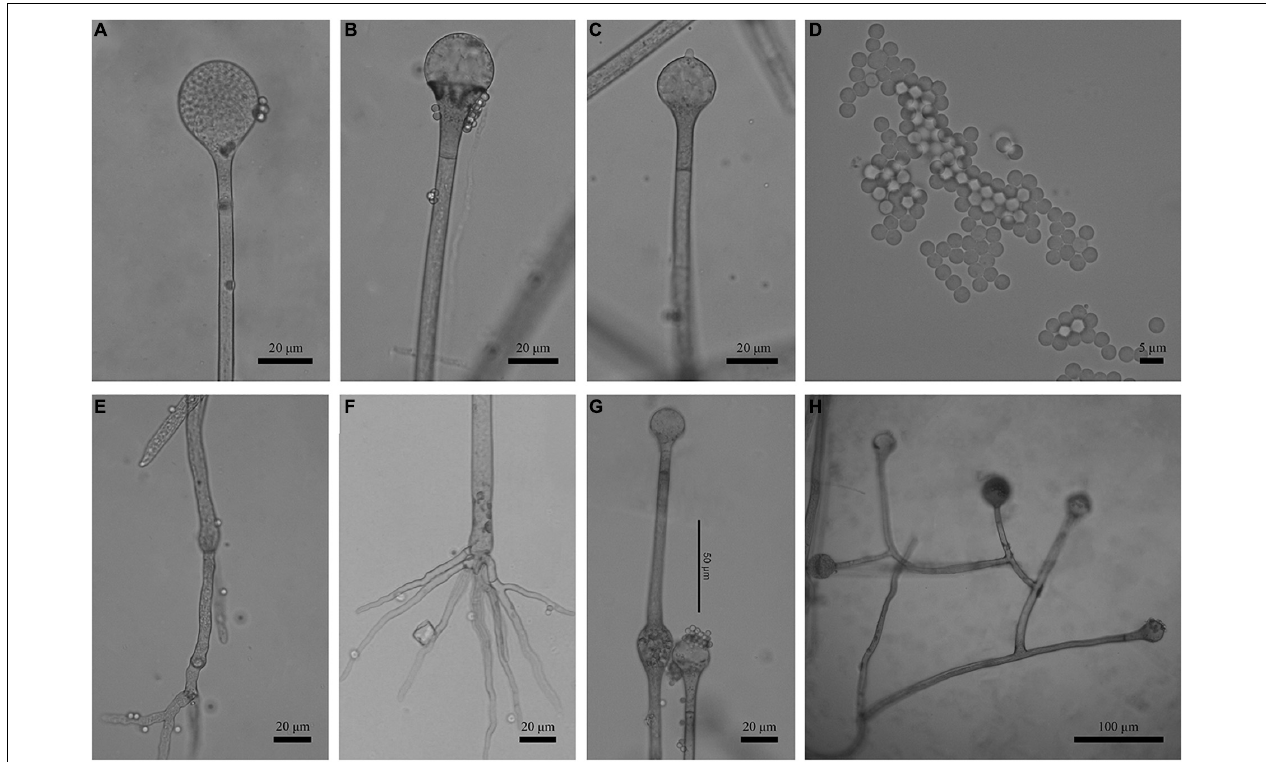
FIGURE 3 | Morphologies of Absidia globospora CGMCC 3.16031. (A) Sporangium; (B,C) columellae; (D) sporangiospores; (E,F) rhizoids; (G) swelling on sporangiospores; (H) sympodial sporangiophores. Scale bars: (A–C,E–G) 20 µ m; (D) 5 µ m; (H) 100 µ m.